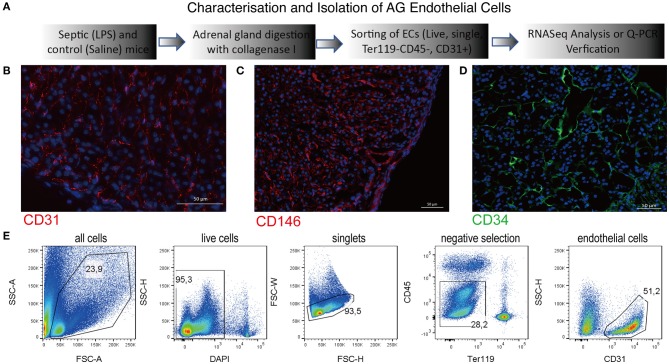
Characterization of the adrenal gland microvascular endothelial cells. Schematic representation of the procedures used to isolate and to characterize the adrenal microvascular endothelial cells (A). Fluorescent staining of the mouse adrenal gland sections for endothelial-specific markers such as CD31 (PECAM) (B), CD146 (MCAM) (C), and CD34 (D). CD31 and CD146 were visualized using secondary antibodies coupled to Cy3 dye (red color), and CD34 was visualized using secondary antibodies coupled to 488 dye (green color). Representation of the multiparametric FACS sorting technique used to isolate adrenal microvascular endothelial cells (E). The gating strategy was based on negative selection. Only alive, single cells that were CD45 negative (devoid of immune cells) and Ter119 negative (devoid of erythrocytes) but CD31 positive (endothelial cells) were sorted.